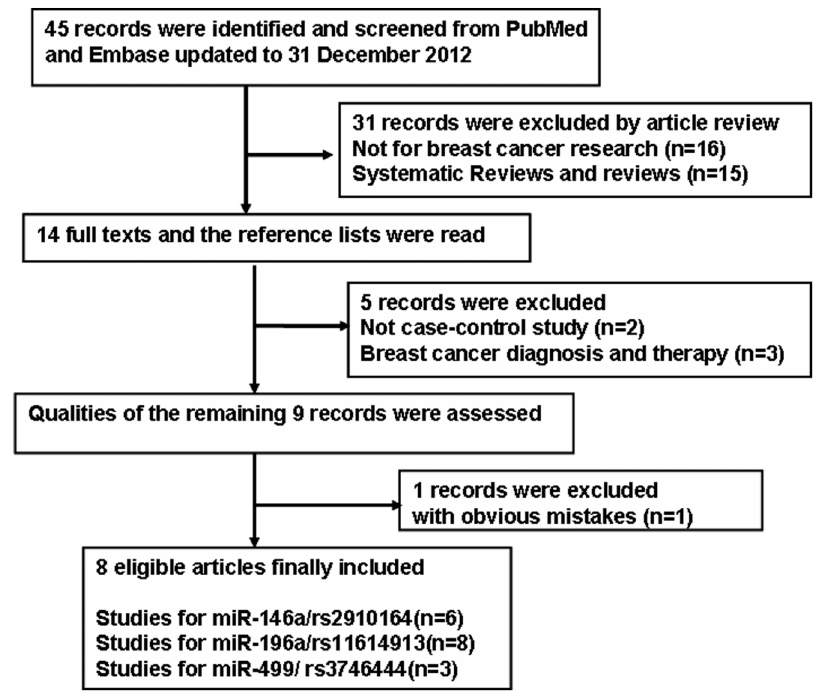
Figure 1. Flow diagram of selection of studies with criteria for inclusion and exclusion.